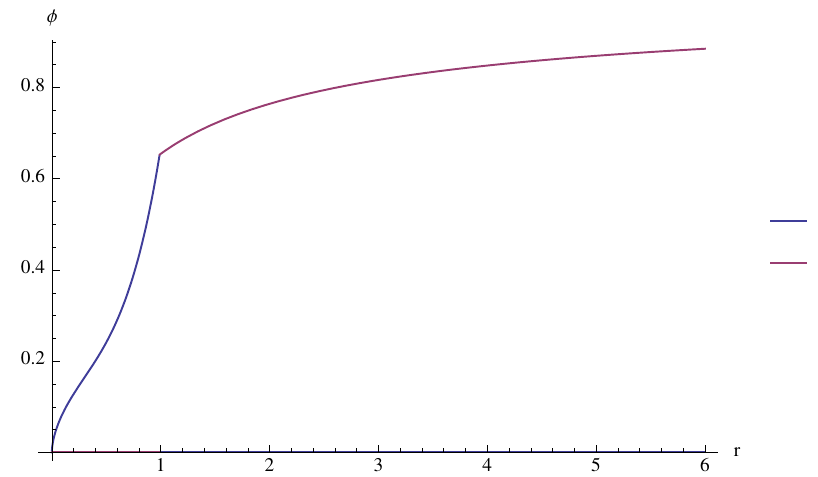
Figure 5 . The scalar (cid:12)eld pro(cid:12)le as a function of the holographic radial coordinate. On the horizontal axis, we have used the conformal coordinate r = R e (cid:0) A du . In this coordinate, the AdS boundary is at r = 0, and the (regular) IR horizon, is reached as r ! + 1 , where ’ ( r ) approaches the (cid:12)xed point value ’ IR = 1. The solution is obtained by (cid:12)xing the initial condition at